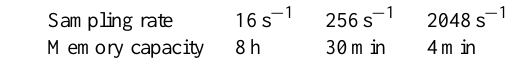
Table 2. Summary of typical EMMA data memory